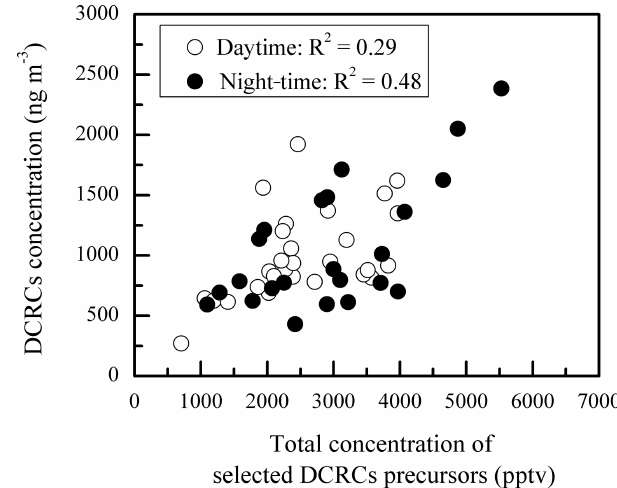
Figure 5. Scatter plot of the day and night concentrations of DCRCs and selected DCRC precursors. Here, the total concentration of se- lected DCRC precursors is the summed concentration of ethyne, ethene, isoprene, α -pinene, β -pinene, toluene, m/p -xylene and o- xylene.